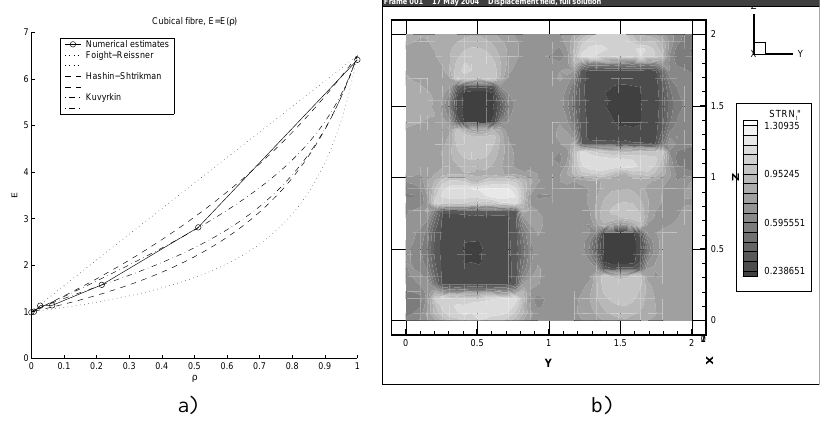
Figure 2. a) Simulated values of Young modulii, cubic fibers ( Al (cid:0) SiC ), b) strain field at x = 0 : 5 . Table 1. Theoretical estimates, (cid:26) = 0 : 243 . Foight-Reissner Hashin-Shtricman